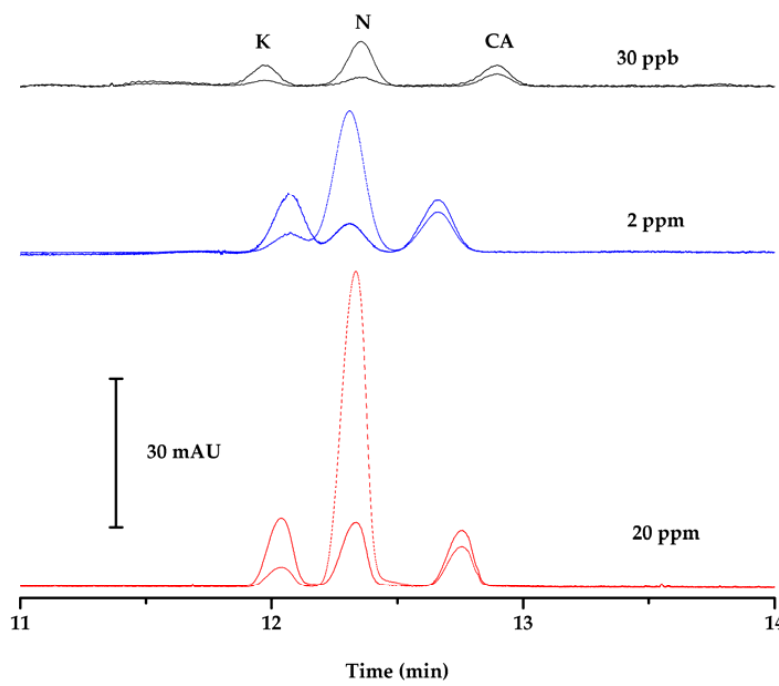
Figure 6. Electropherograms obtained under optimum conditions of standard solutions of ketoprofen (K), naproxen (N), clofibric acid (CA) at 20 mg · L − 1 without SPME (solid-phase microextraction) and ACN (acetonitrile) stacking (red), at 2 mg · L − 1 with ACN stacking (blue), and at 30 µ g · L − 1 after SPME and ACN stacking (black), at 203 nm (straight line) and 228 nm (point segmented line).